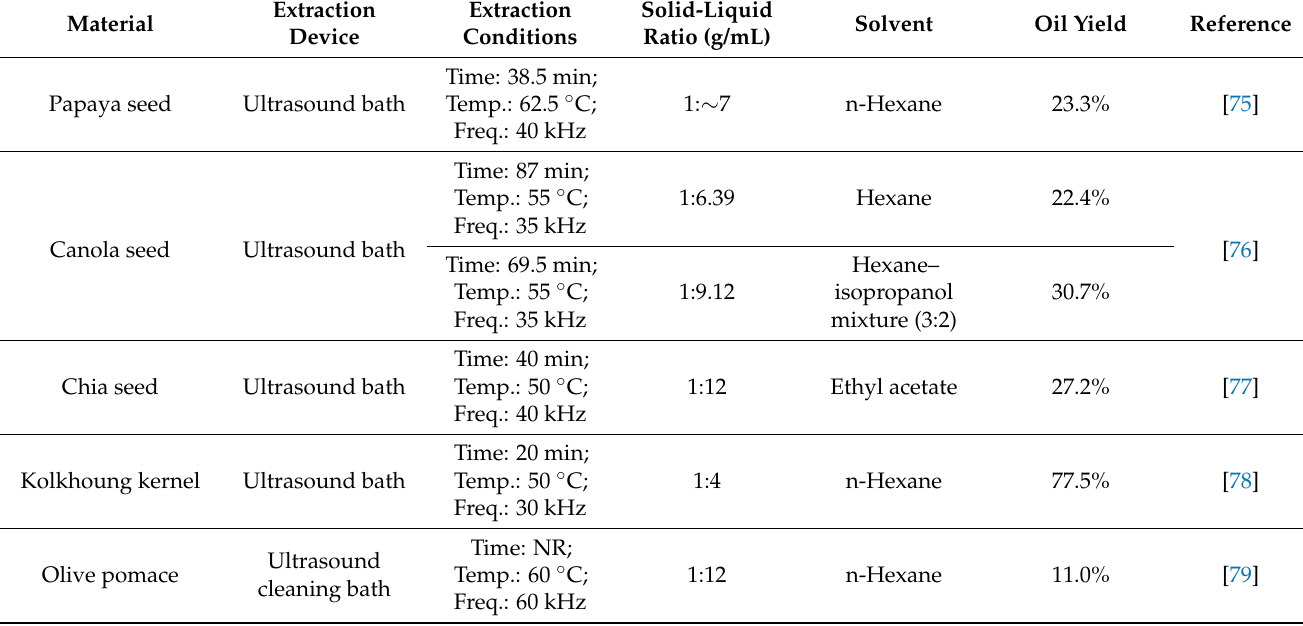
Table 3. Extraction of oils by ultrasonic-assisted